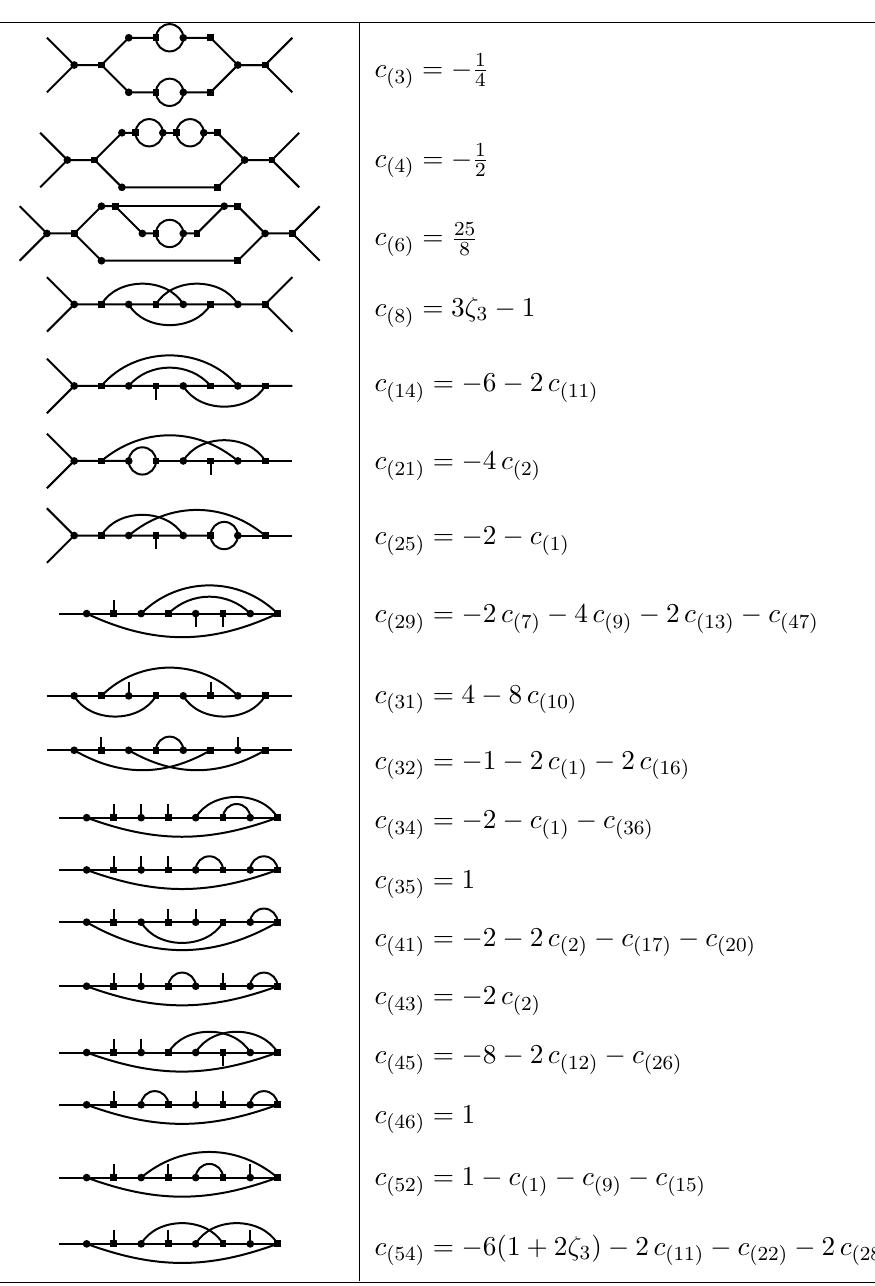
Table 1 . Relations between coefficients for tensor structures in figure 4 and figure 5 (left), inferred from comparison with supersymmetric RGEs. The corresponding graphs on the right contain round vertices denoting an insertion of Y ABC while squared nodes mark Y ABC